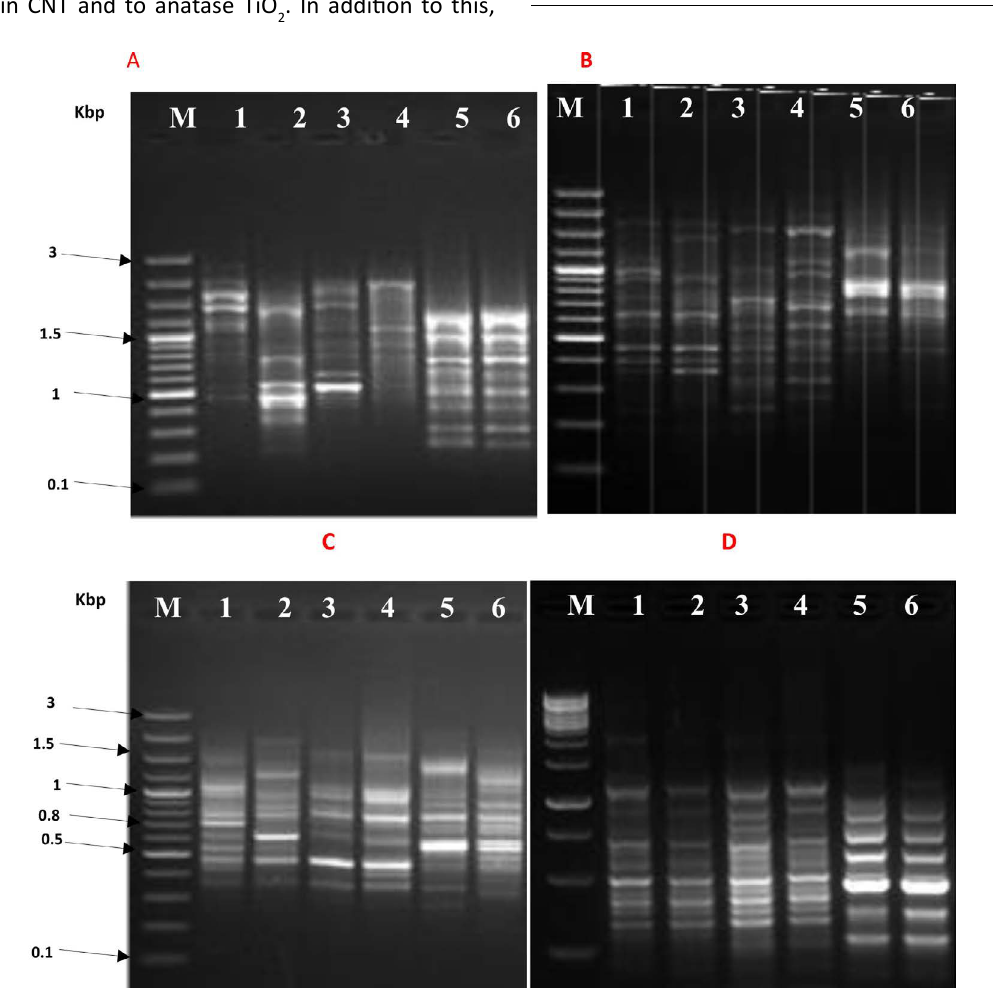
Fig. 3 . RAPD PCR profile of E. coli by using 10 mer primer lane M: 100 pb plus marker, panel A, B, C, and D- lane 1: bacterial growth after 10 hr without nanoparticles, lane 2: bacterial growth after 10 hr with nanoparticles, lane 3: bacterial growth after 14 hr without nanoparticles, lane 4 : bacterial growth after 14 hr with nanoparticles, lane 5: bacterial growth after 18 hr without nanoparticles, lane 6: bacterial growth after 18 hr with nanoparticles.